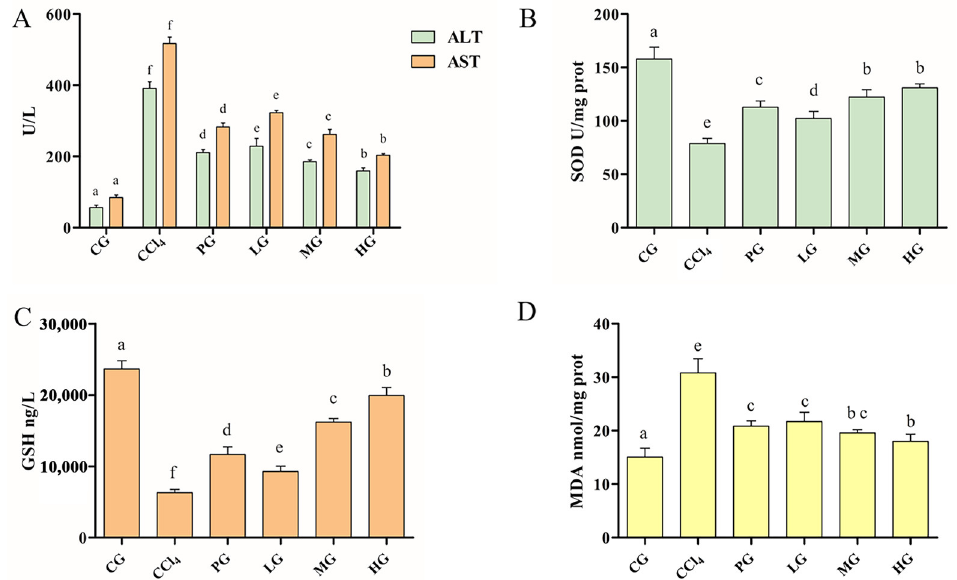
Figure 2. Effect of the ethanol extract of G42 on serum marker enzymes and oxidative stress level in the liver of acute liver injury caused by CCl 4 . ( A ) ALT and AST and ( B ) SOD level. ( C ) GSH and ( D ) MDA. The results are shown as mean ± SD. Different letters above each bar in the same parameter indicate a significant difference ( p < 0.05) ( n = 5).